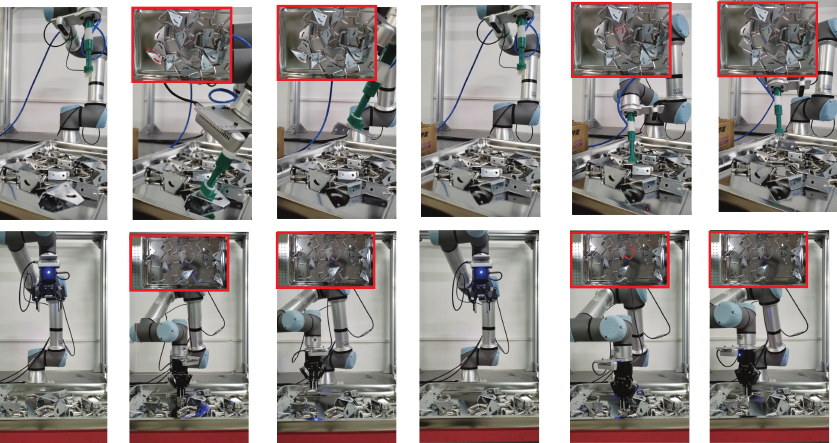
Figure 9. Robot grasping demonstration. Our method can segment each object instance automatically and estimate its 6D pose, then the robot grasps or sucks the recognized